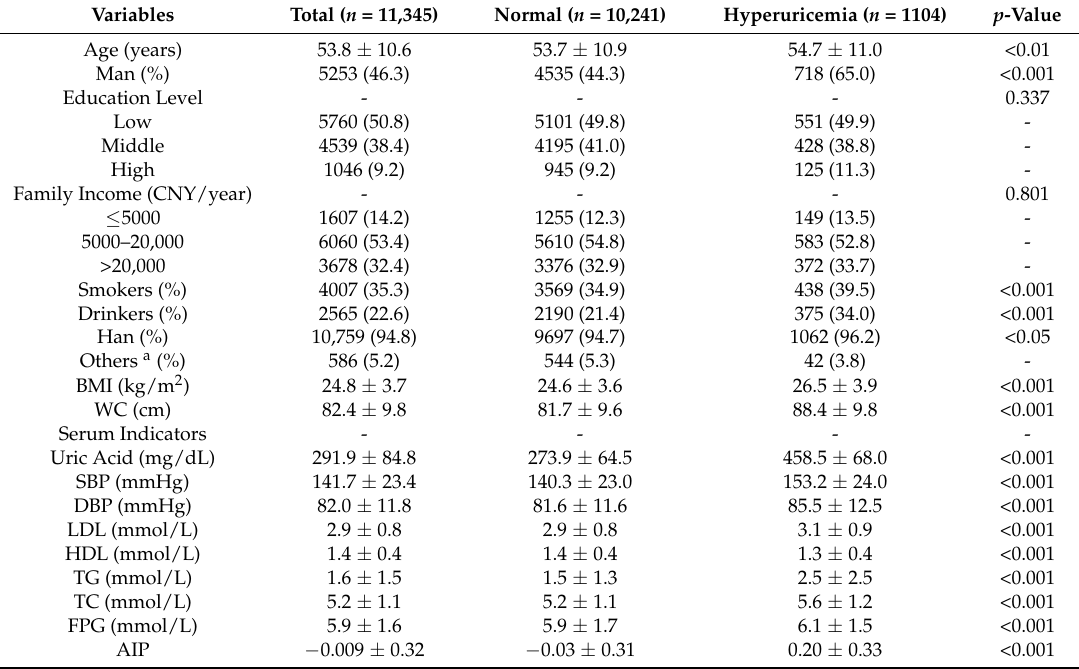
Table 1. Baseline characteristics of study